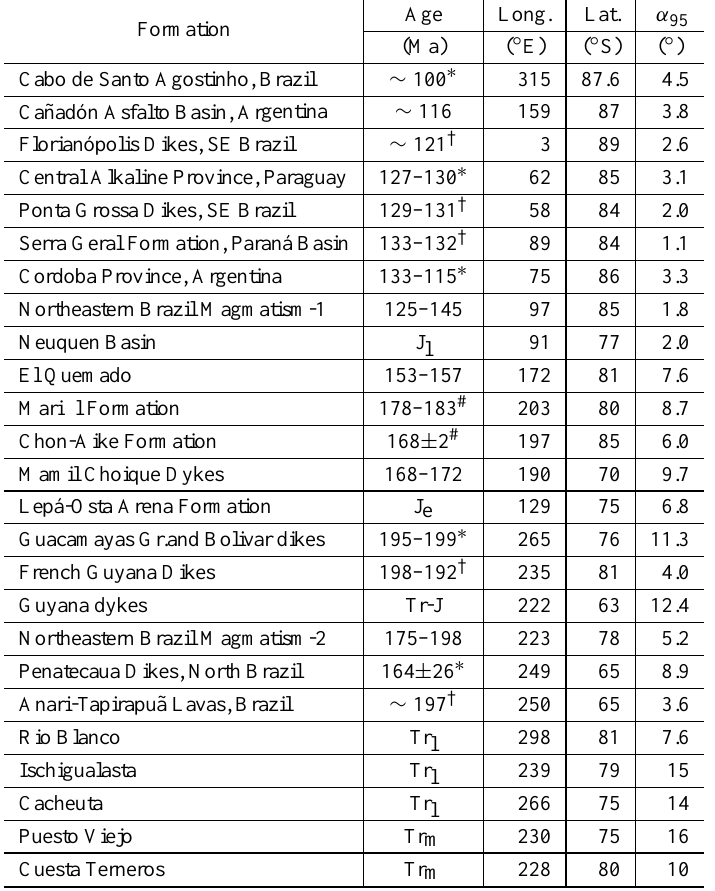
Selected Mesozoic paleomagnetic poles for South America based on compilations by Ernesto et al. (2002), Iglesia Llanos et al. (2003) and Vizán et al. (2004). Age Formation